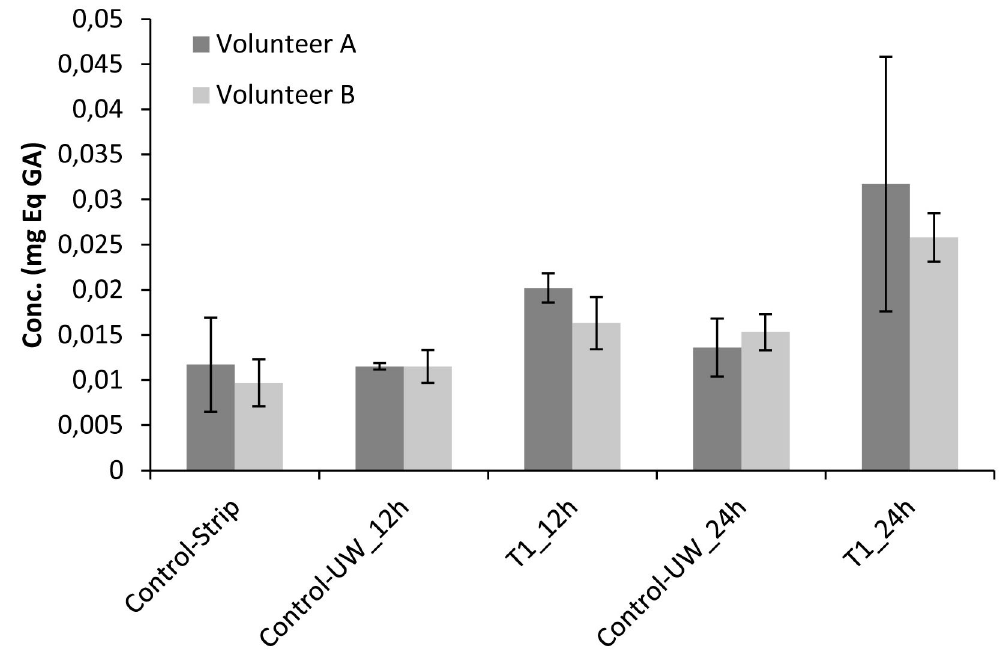
Figure 4. Values expressed as mg Eq. GA obtained from control, control-textiles and biofunctional textiles after 12 and 24 h of application onto the skin of the two healthy volunteers. UW is for ‘untreated wool’; T1 refers to Textile #1. All analyses were performed in